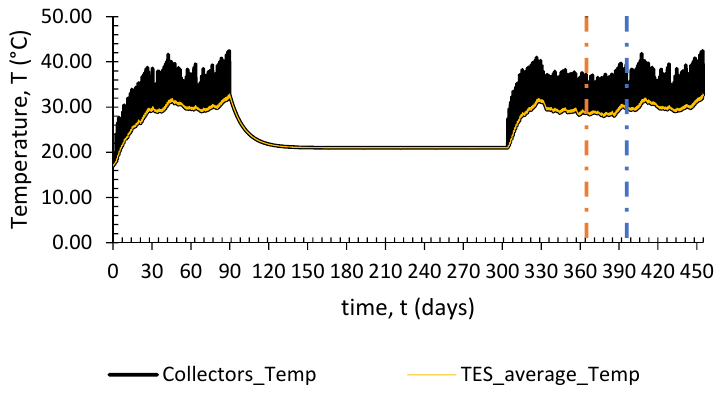
Figure 5. Yearly results of solar collectors’ (with an 8 m 2 area) outlet temperature and the rise of TES unit average temperature; the orange dashed line indicates the simulation start time and the blue dashed line the end time.